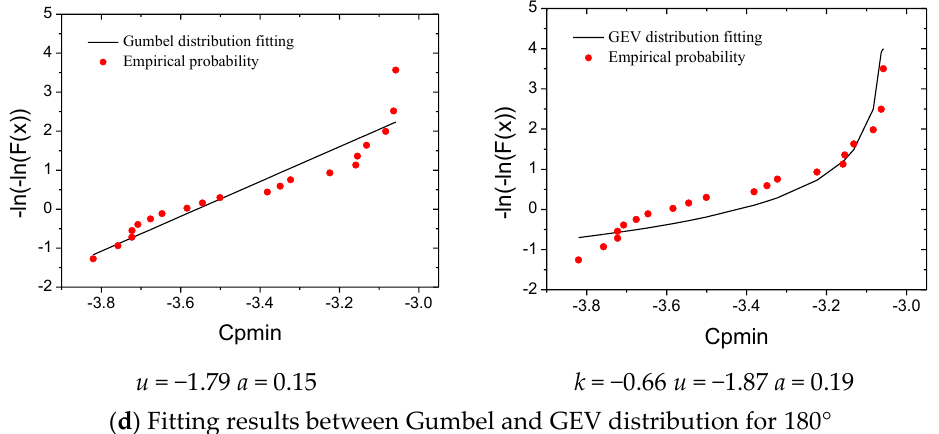
Figure 6. Fitting results of the probability distribution of extreme pressure coefficient under different wind direction angles: ( a ) Fitting results between Gumbel and GEV distribution for 45°, ( b ) Fitting results between Gumbel and GEV distribution for 60°, ( c ) Fitting results between Gumbel and GEV distribution for 90°, ( d ) Fitting results between Gumbel and GEV distribution for 180°.